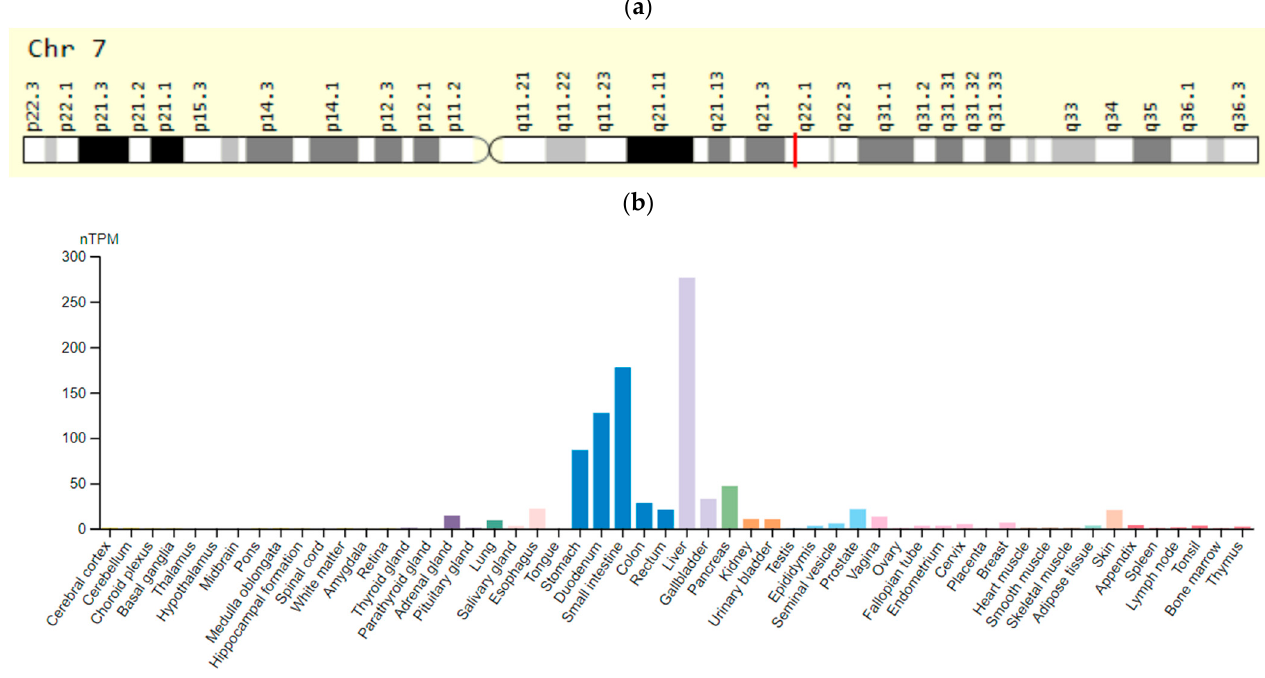
Figure 8. The CYP3A5 gene: ( a )–gene chromosome location; ( b )–protein expression in tissues of the human body [82,83].